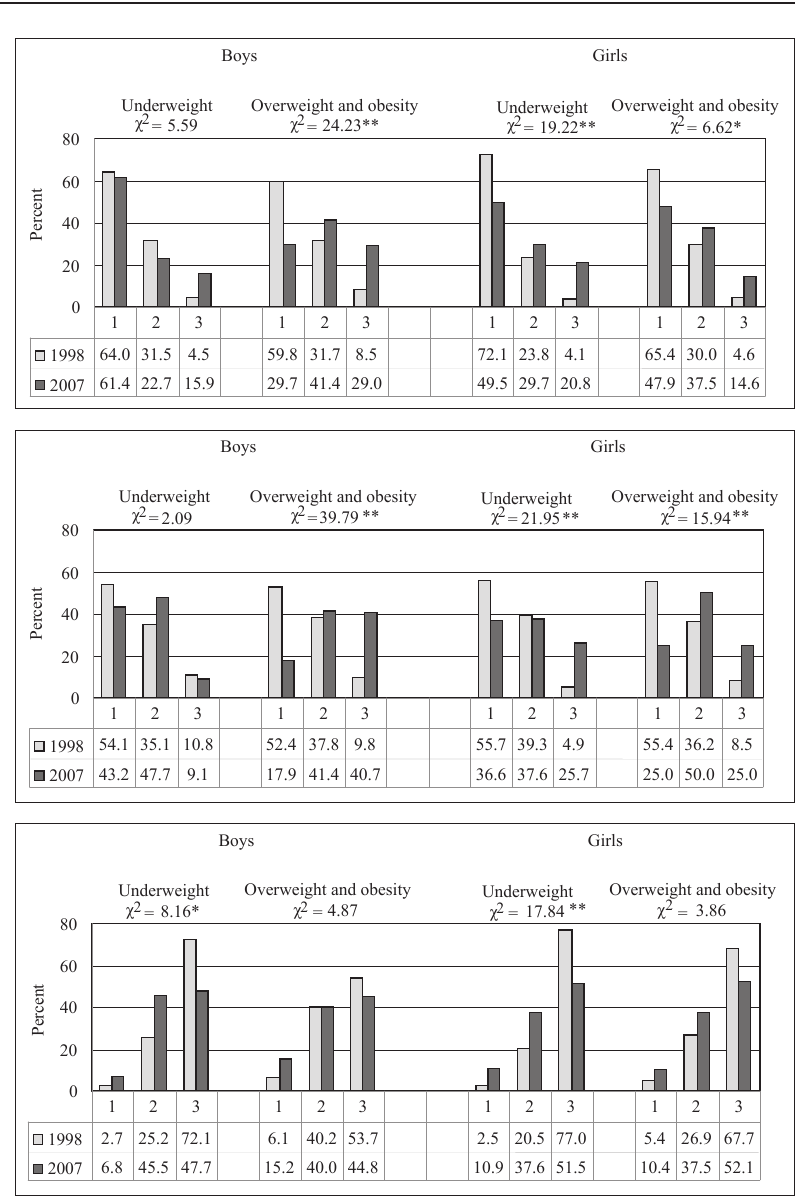
Note. * – statistically signi fi cant differences on the level p < 0.05; ** – statistically signi fi cant differences on the level p < 0.01. Number of children: 1 – one child, 2 – two children, 3 – three and more